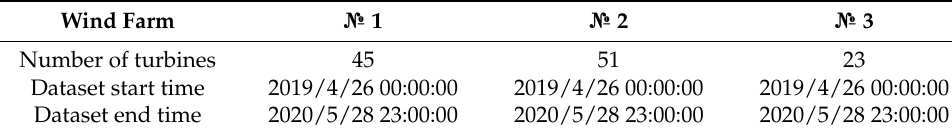
Table 4. Description of three wind farm